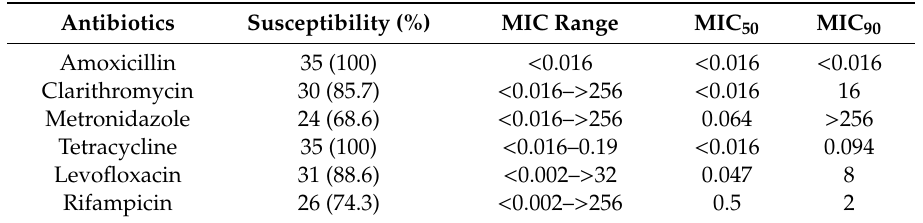
Table 4. Susceptibility and MIC values for 35 isolated H. pylori strains.